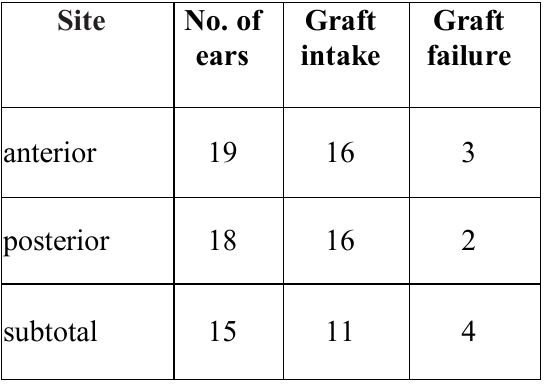
Table 6(a): Audiological results in successful